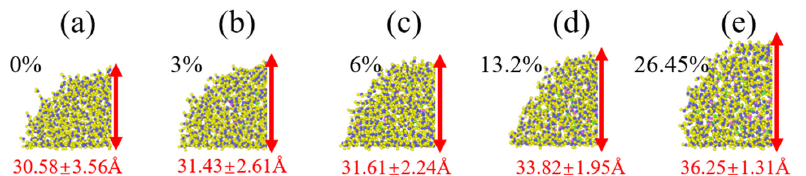
Figure 4. Height of physiological saline at different NaCl concentrations. ( a ) 0%, ( b ) 3%, ( c ) 6%, ( d ) 13.2%, ( e ) 26.45%.